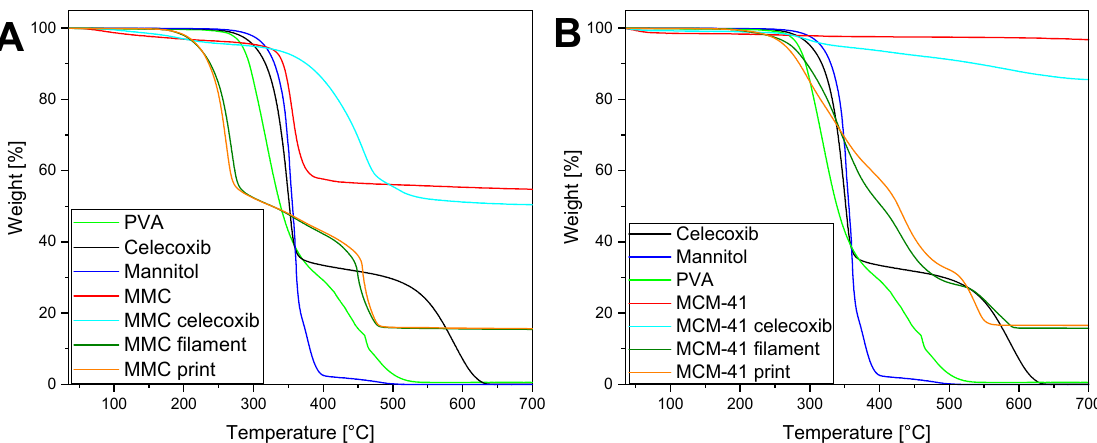
Figure 6. TGA thermograms of filaments, tablets, and individual components; ( A ) MMC-containing formulations; ( B ) MCM-41-containing formulations.